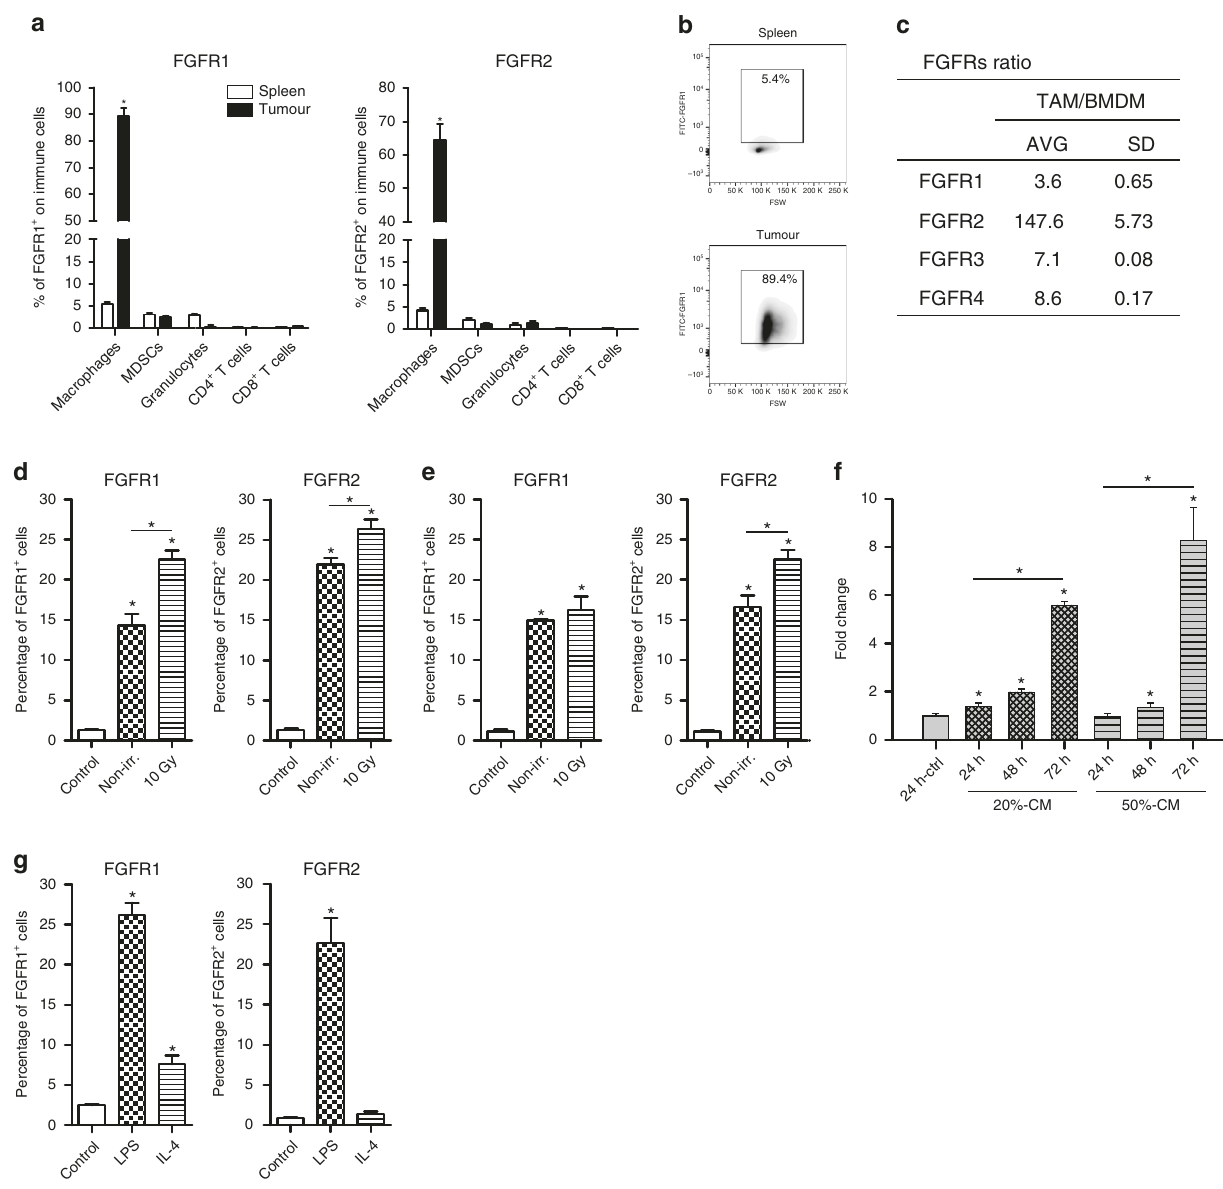
Fig. 2 Tumour-associated macrophages express FGF receptors. a Analysis of expression of FGFR1 and FGFR2 on immune cells from the spleen (open bars) and MC38 subcutaneous tumours ( fi lled bars) using fl ow cytometry and ( b ) representative fl ow cytometry plots for FGFR1 in the spleen and tumour. c Compares RNA for FGFRs1-4 from TAMS to BMDM using qPCR. d FGFR1 and FGFR2 expression in WT BMDM macrophages following 24 h of co-culture with non-irradiated or irradiated MC38 tumours cells. e FGFR1 and FGFR2 expression in WT BMDM macrophages following 24h of co-culture with non- irradiated or irradiated KPC tumours cells. f Fold change in FGFR1 RNA in BMDM after 24 h exposure to MC38 conditioned medium . g FGFR1 and FGFR2 expression in WT BMDM macrophages following stimulation with LPS or IL4. N = 6 in each cells with WT BMDM did not affect tumour growth at a 1:1 or 1:4 ratio (Fig. 5c). In contrast, co-injection of Fgf2 LMW − / − BMDM